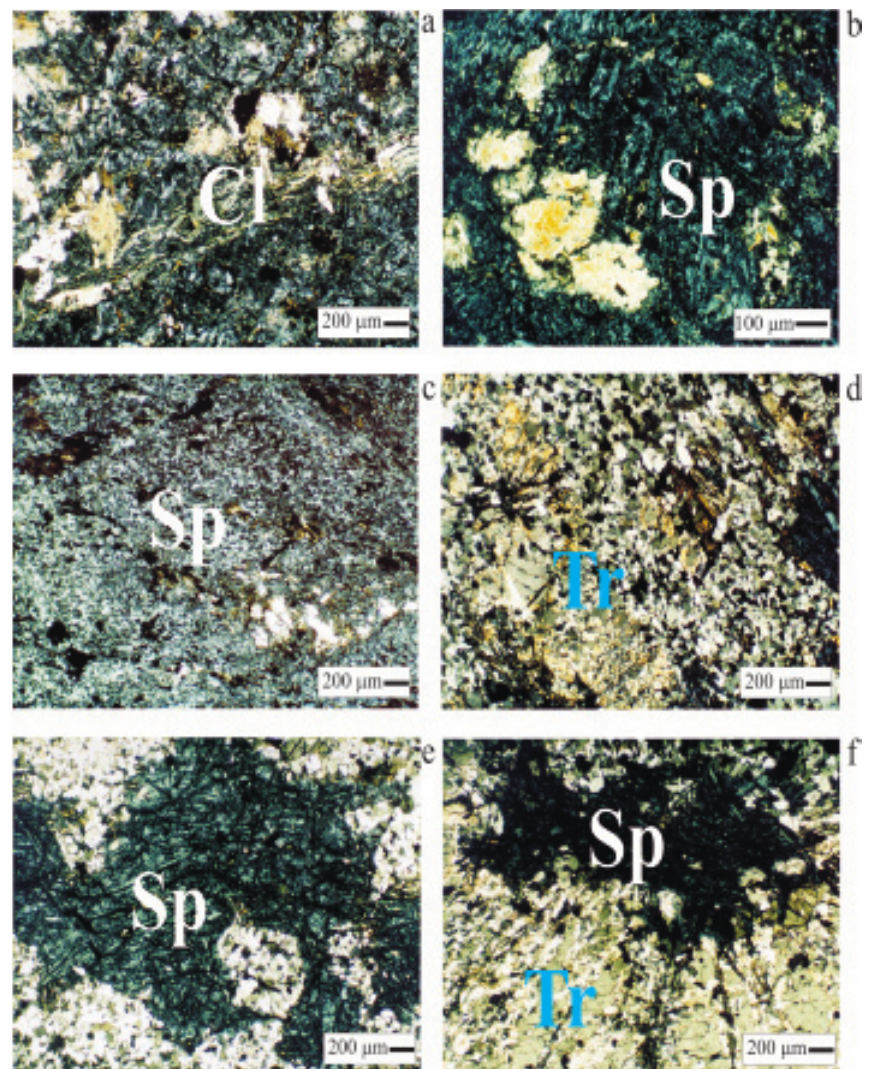
Figura 2. (a): Fotomicrografias sob luz poralizada das rochas coletadas em P1, P2 e P3 e (b): serpentinito com restos de tremolita grosseira e clorita (Cl) em P1; c: serpentinito com restos de tremolita e clorita em P2; de e f: tremolita xisto com manchas de serpentinito no P3. Sp: serpentina; Tr: tremolita; Cl: